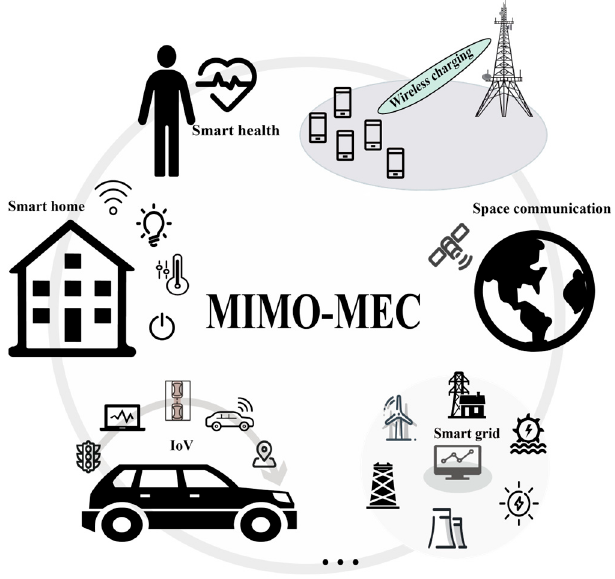
Figure 4. Some application scenarios of MIMO-MEC.